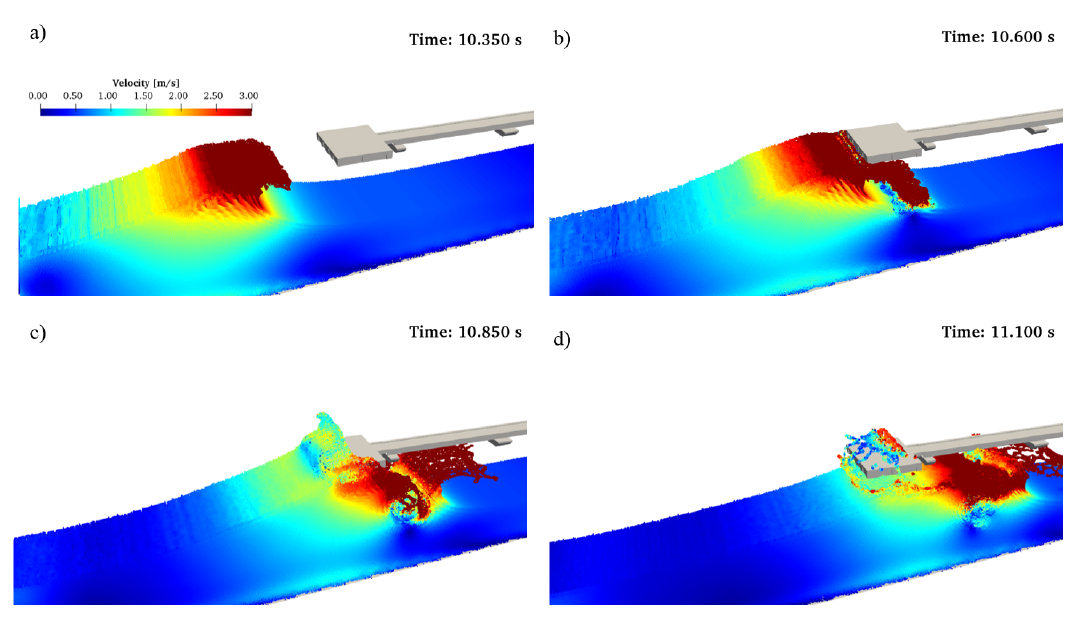
Figure 8. Snapshots of the SPH horizontal velocity contours for the test case B1. ( a ) Time: 10.350 s; ( b ) Time: 10.600 s; ( c ) Time: 10.850 s; ( d ) Time: 11.100